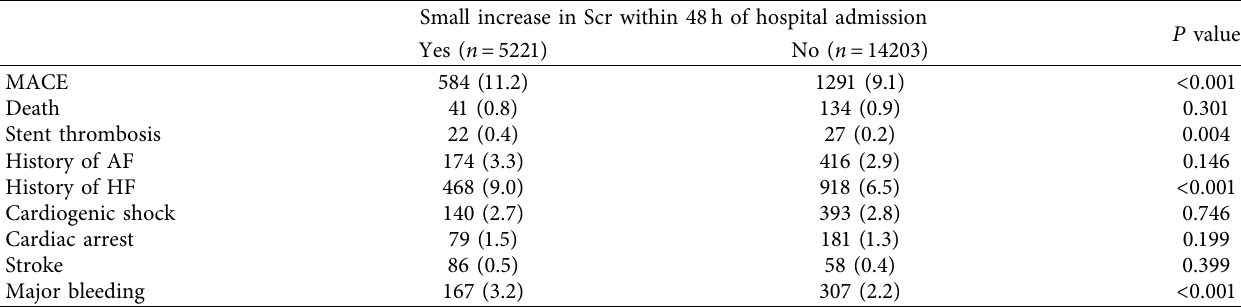
Table 2: Primary analysis: in-hospital outcomes for patients with STEMI who underwent primary PCI ( n � 19,424).